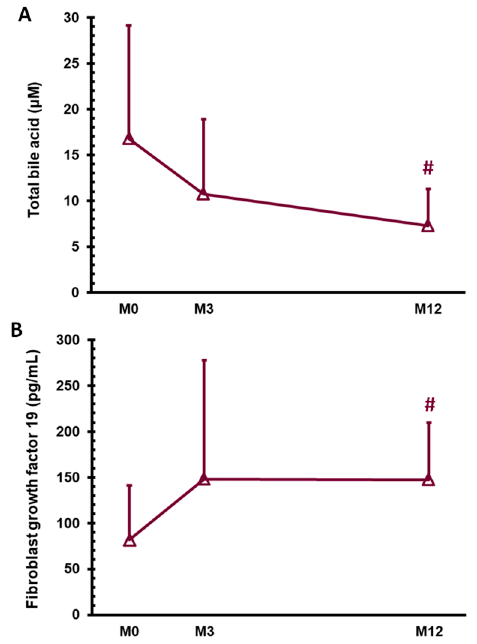
Figure 1. Serum levels of total bile acid ( A ) and fibroblast growth factor 19 ( B ) in patients with obesity and type 2 diabetes mellitus before (M0) and 3 months (M3) and 1 year (M12) after sleeve gastrectomy. # p < 0.05 compared with M0.